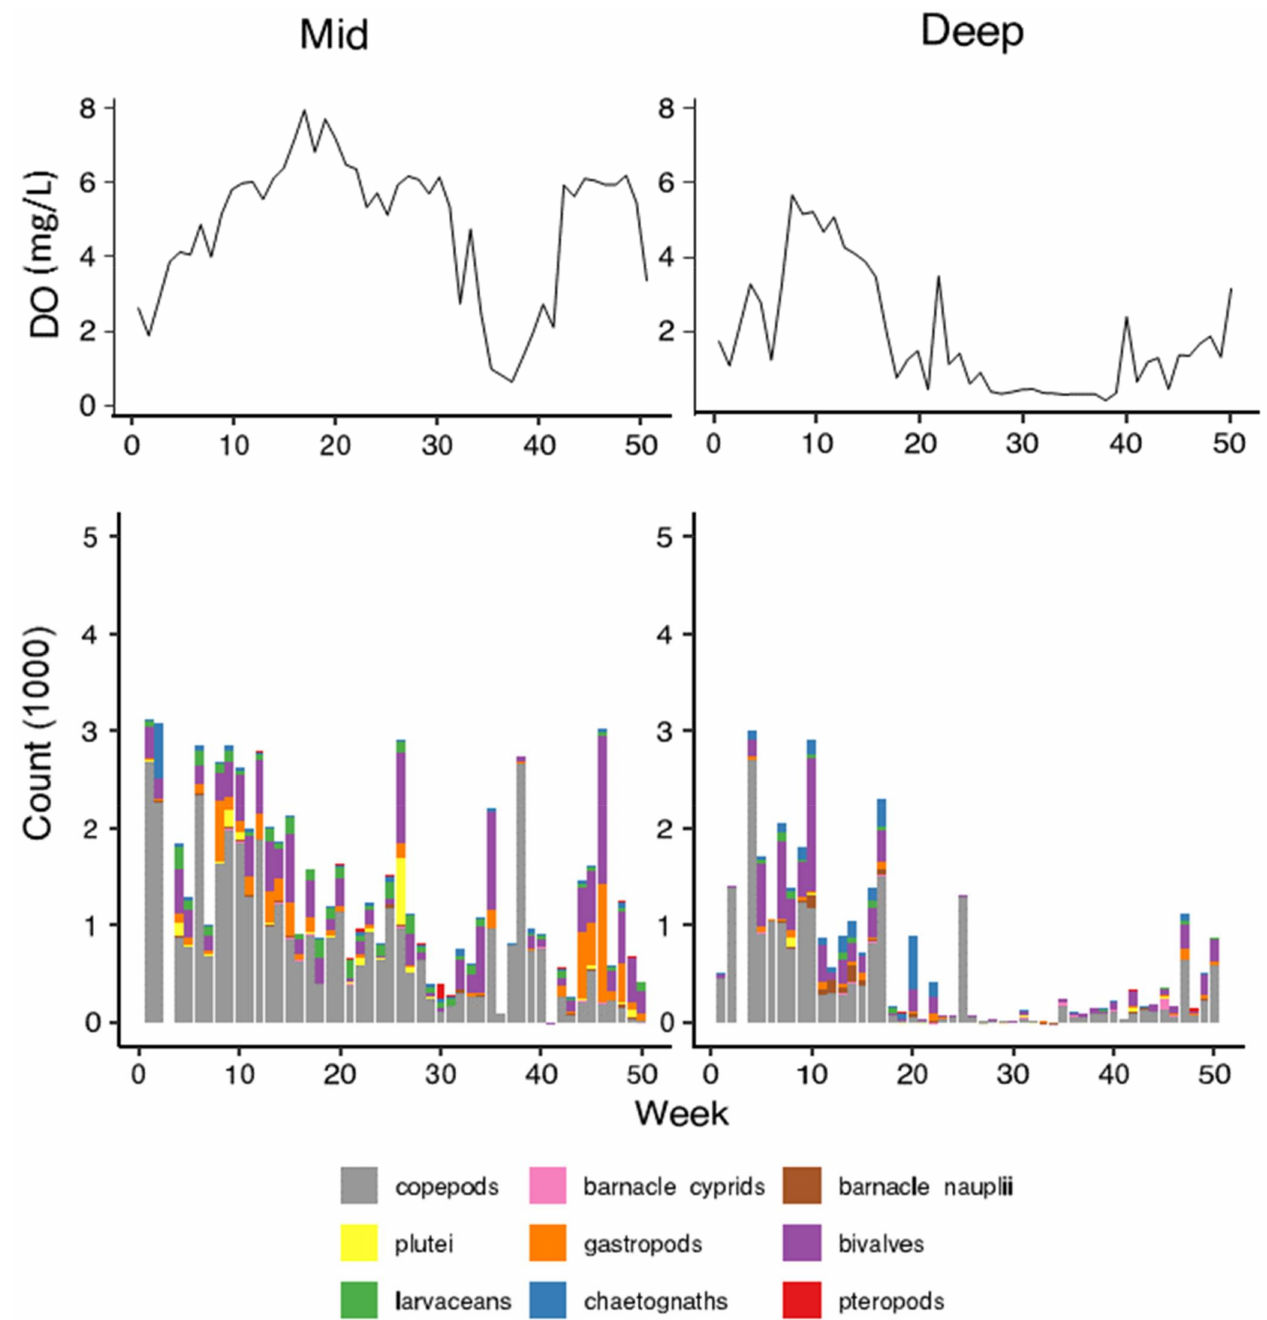
Figure 6. Dissolved oxygen and abundances of the nine focal plankton groups at Pastores over the 50 weeks of this study, plotted by depth. Count values reported as 1000’s per 379 L